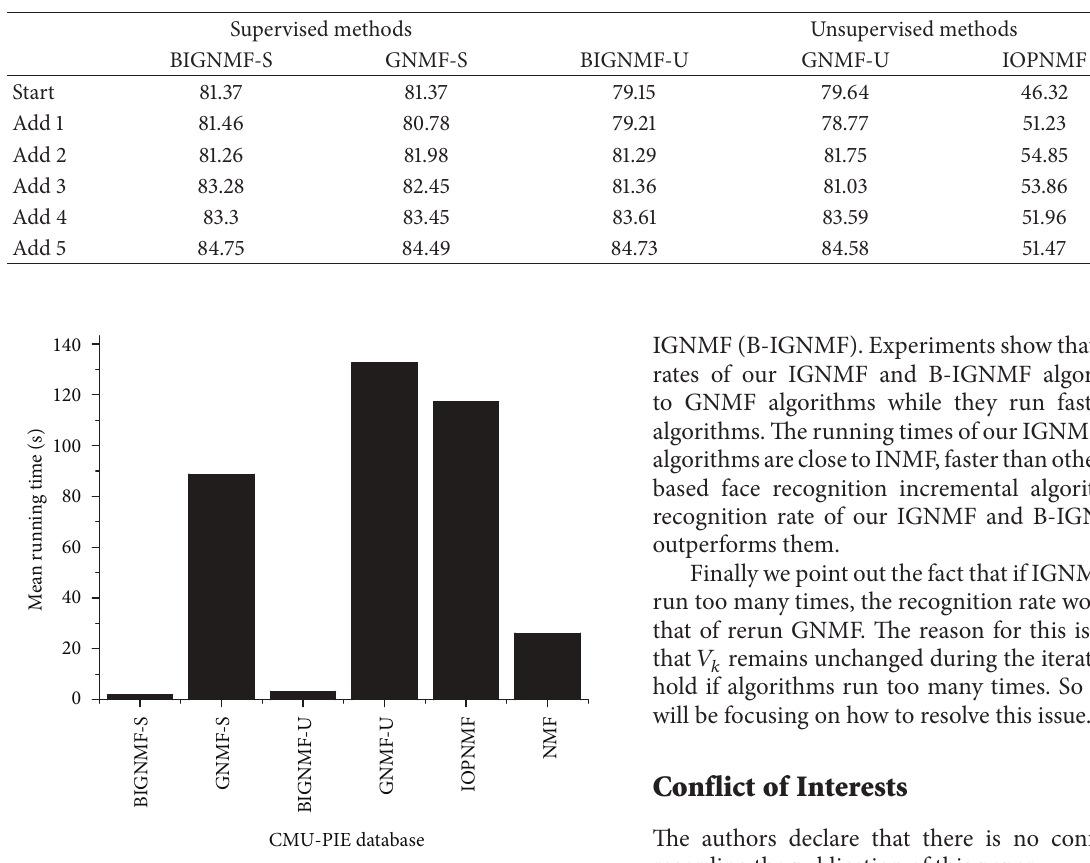
Figure 10: The mean running time during incremental study with images belonging to different classes for the CMU-PIE